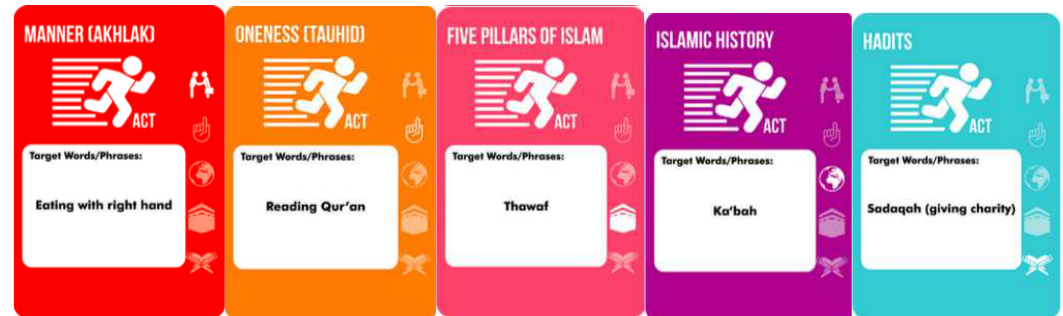
Figure 4. The ‘saying cards’ of the trivia cards